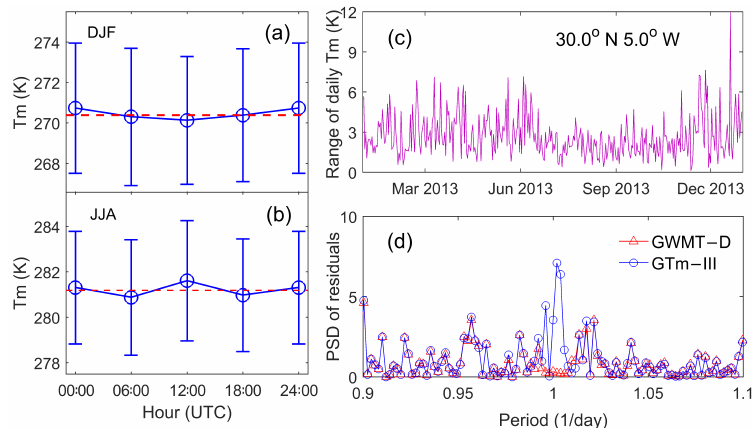
Figure 2. Statistical results of diurnal T m (mean ± standard deviation) at 2km height and four reference times during (a) December–January– February (DJF) and (b) June–July–August (JJA) in 2013, (c) the range of daily T m (max − min), and (d) power spectrum density (PSD) of T m residuals.